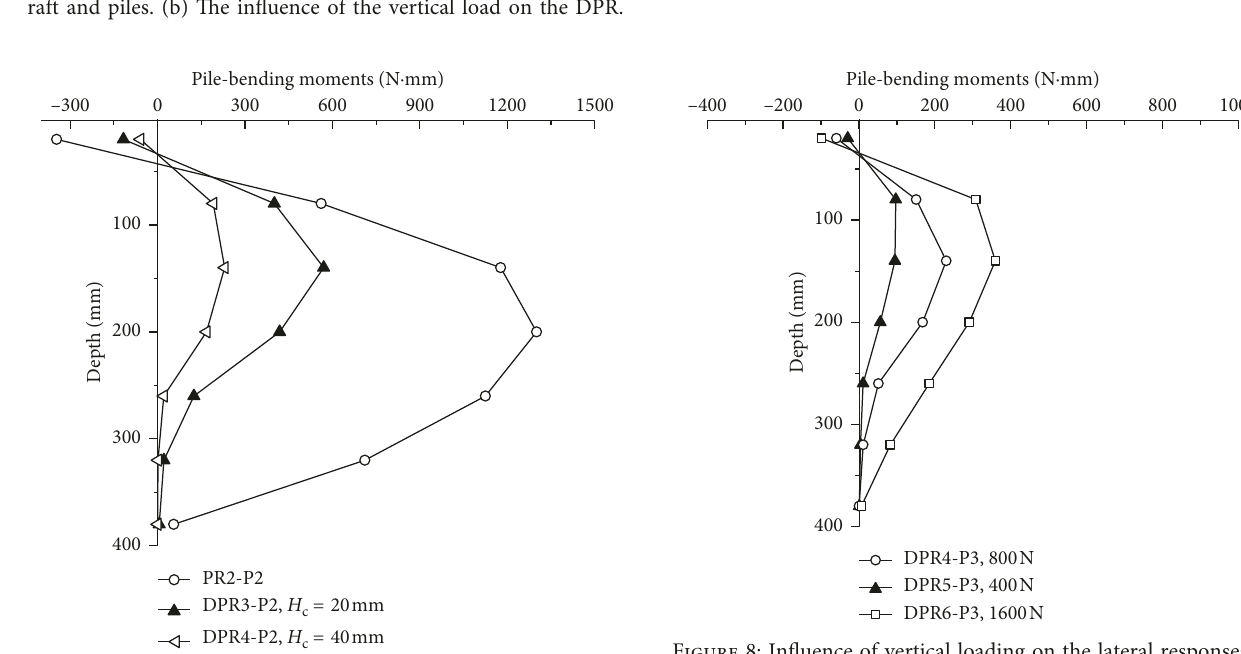
Figure 7: Influence of the interposed layer on the responses of the pile bending moments under a 300 N horizontal force.